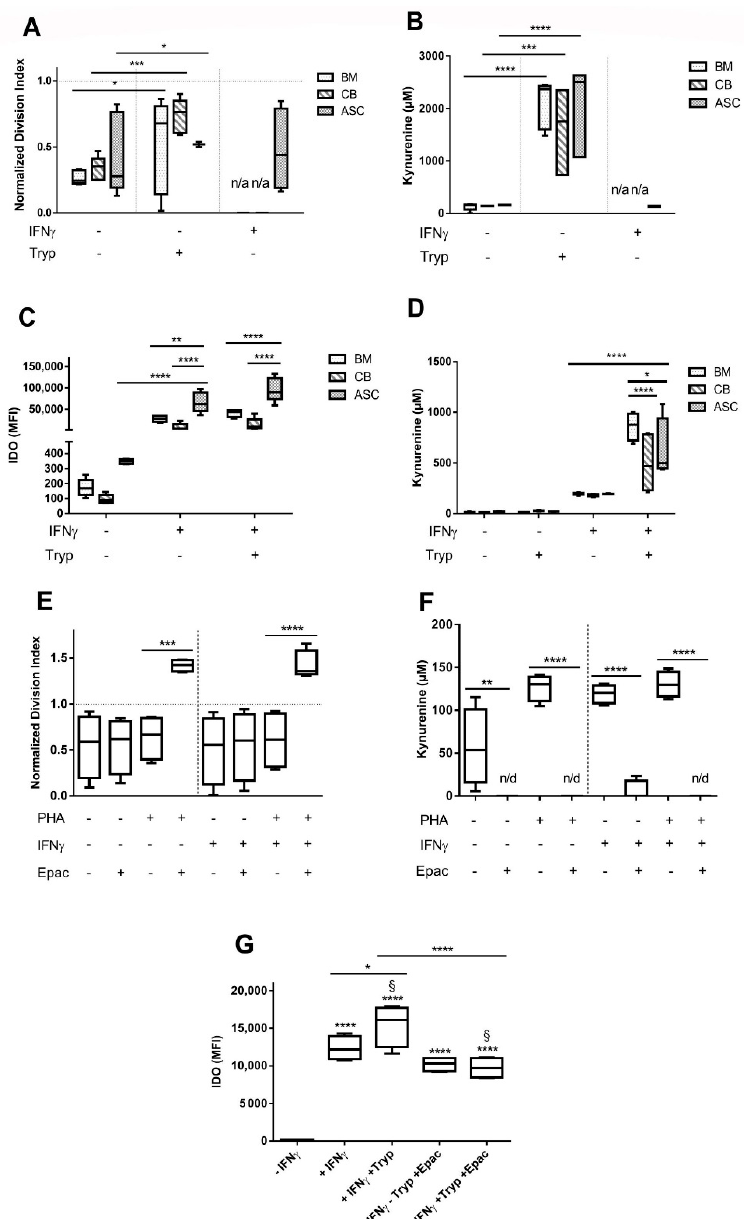
Figure 2. IDO expression is induced by IFN γ stimulation and further increased with the addition of tryptophan, which in turn largely abrogates MSC inhibitory potential. ( A ) MSC:PBMC cocultures were set with BM, CB and ASC cells. Addition of IFN γ and Tryp were tested, n = 5 to 8. ( B ) Kynurenine coculture concentrations measured in presence of IFN γ and Tryp, n = 5 to 8. ( C ) IDO production is significantly increased when MSC are stimulated with IFN γ , n = 5. ( D ) Kynurenine concentrations measured in MSC monocultures after IFN γ addition are increased, n = 5. ( E ) ASC:PBMC cocultures were set with the addition of IDO inhibitor, Epacadostat, n = 4. ( F ) Kynurenine coculture concentrations completely abolished in presence of Epacadostat, n = 4. ( G ) IDO secretion in MSC monocultures is reduced when adding Epacadostat ( p < 0.0001, 2-way ANOVA), n = 4. Box: interquartile range; whiskers: minimum to maximum; line: median. Dotted lines represent the normalisation referred to the positive control. Asterisks depicted at the top of the lines represent the significance of the individual value with respect to their own condition control (* p < 0.05, ** p < 0.01, *** p < 0.001, **** p < 0.0001). Symbol § represents the significance of the individual conditions with respect to their positive control (§: p < 0.0001, 2-way ANOVA). Lines with asterisks depict the significance between two